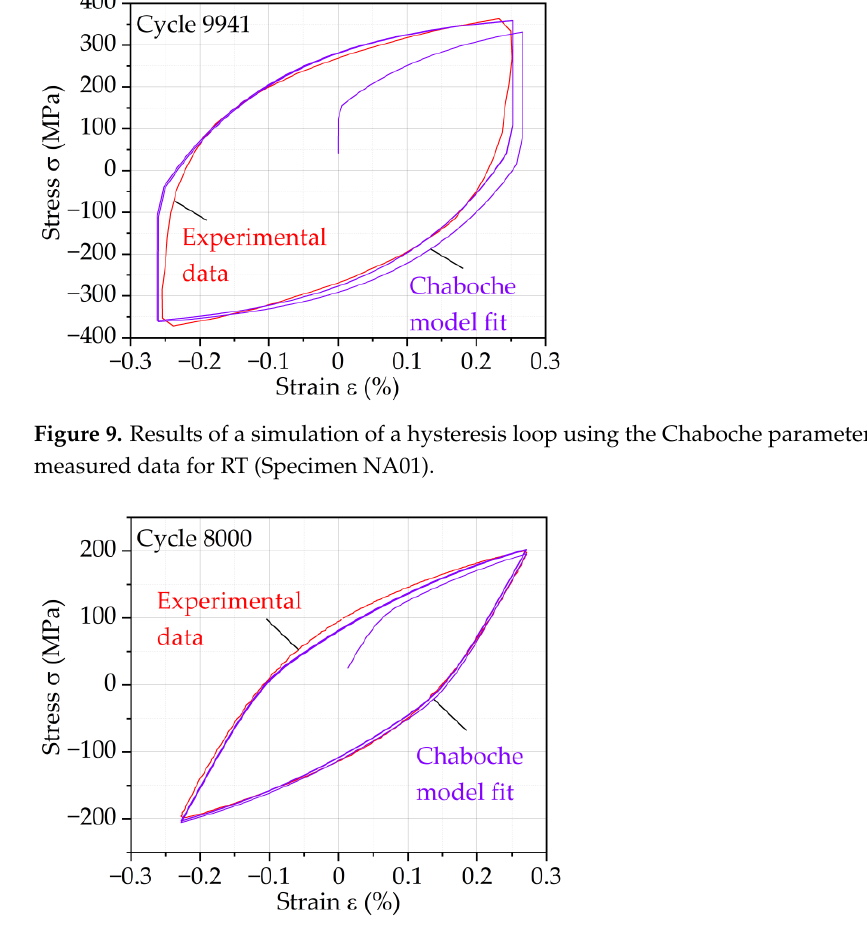
Figure 10. Results of a simulation of a hysteresis loop using the Chaboche parameters compared to measured data for 240 °C.